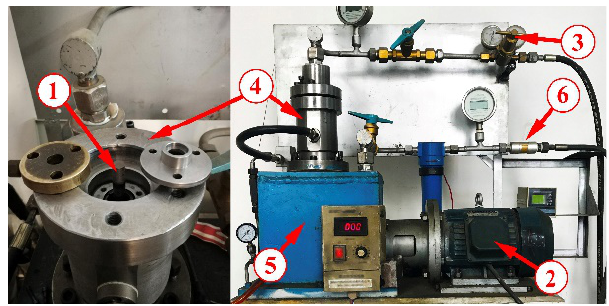
Figure 9. Experimental setup of the test system.